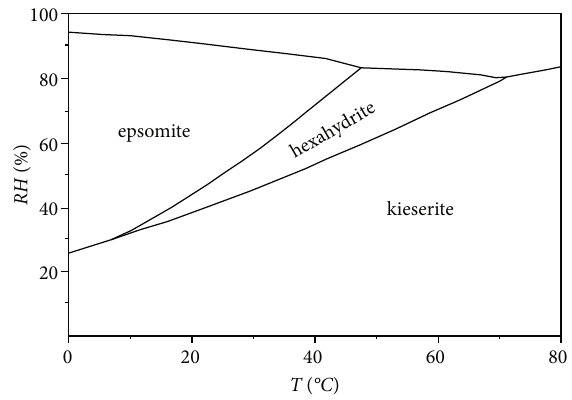
Figure 7: Diagram of existence conditions of epsomite, hexahydrite, and kieserite (modi fi ed from